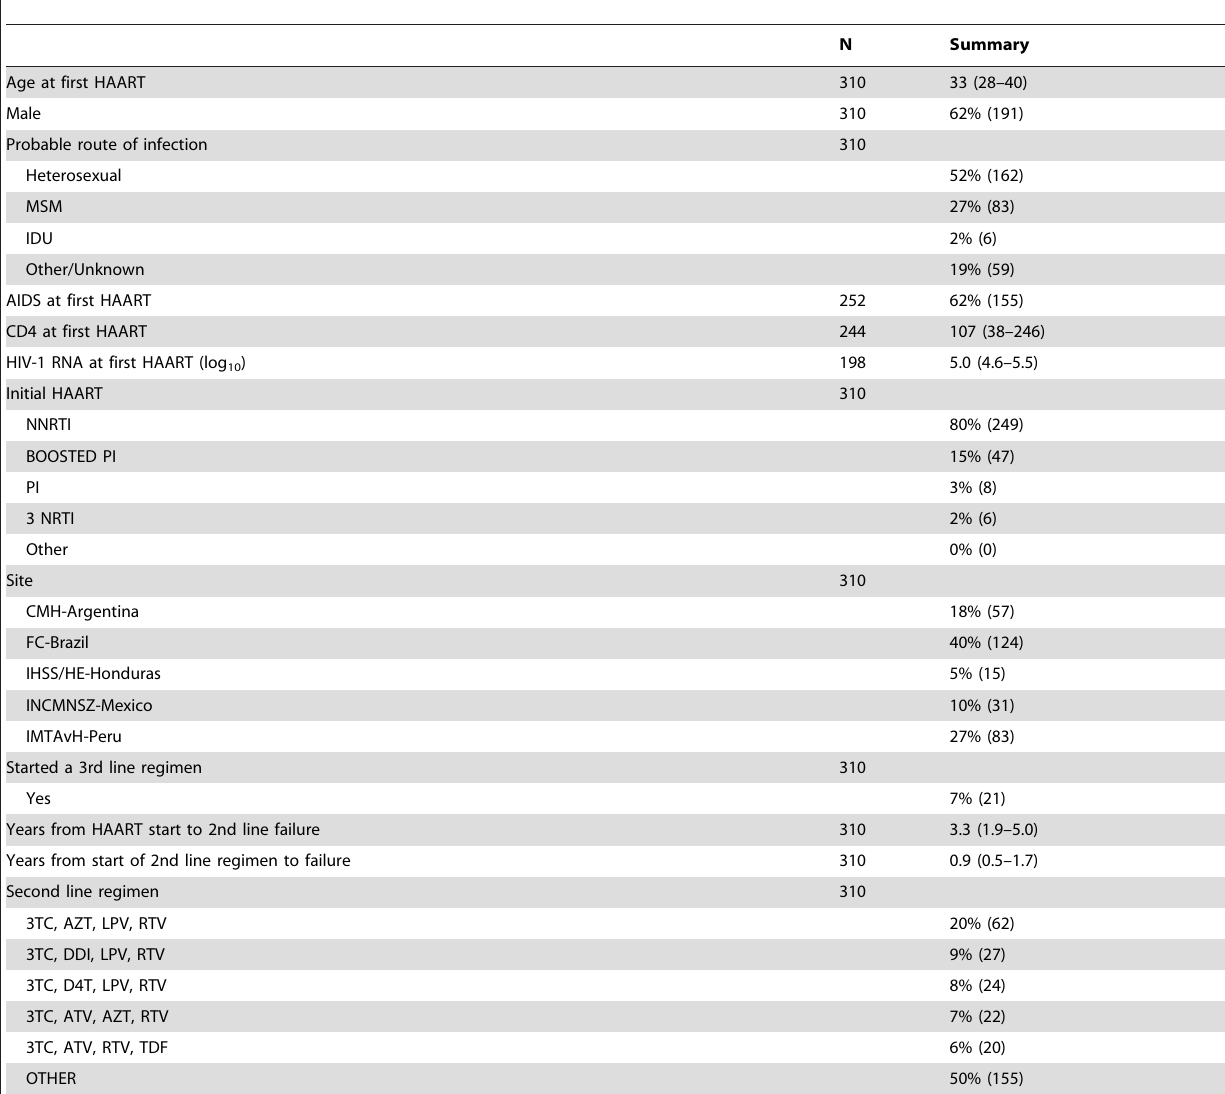
Table 2. Second line virologic failure. Patient descriptive